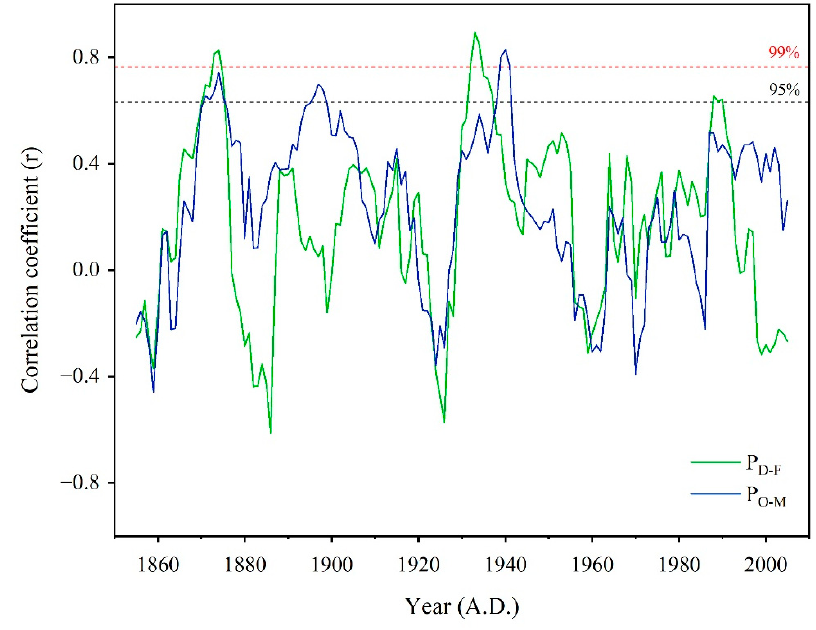
Figure 6. The 30-year moving correlation coefficients between our spring precipitation reconstruction in the Alborz Mountain, northeast Iran, and two precipitation reconstructions from the Zagros Mountains, west Iran, during 1850–2010. P D–F and P O–M represent December to February precipitation in the southern Zagros Mountains during 1850–2015 [5] and October to May precipitation at the central Zagros Mountains during 1840–2010 [34], respectively. Black and red horizontal lines indicate the 95% and 99% confidence limits, respectively.